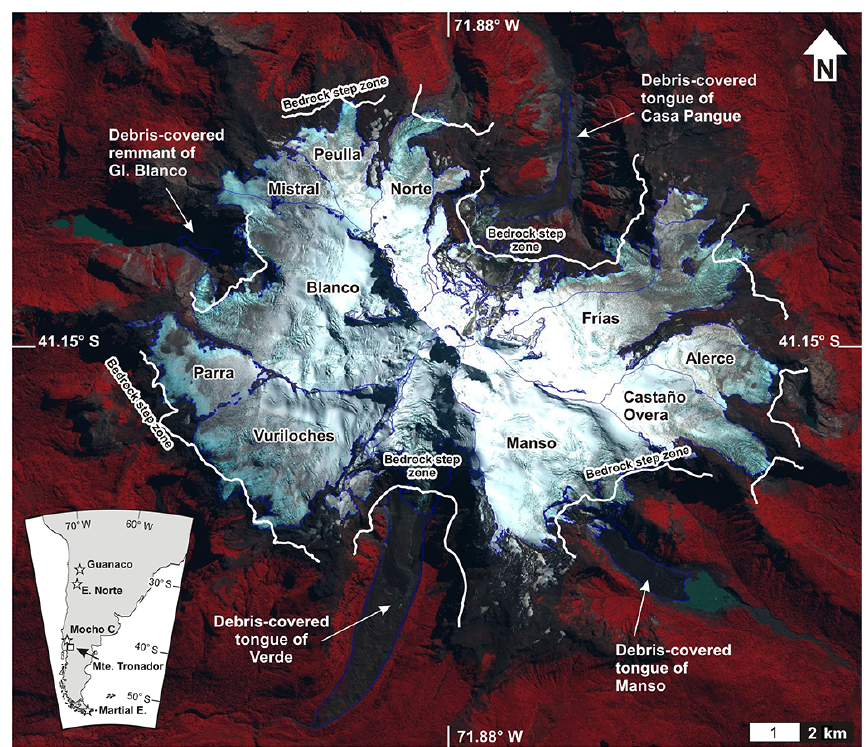
Figure 1. False-colour pan-sharpened Pléiades image of Monte Tronador from 7 March 2012 (RGB bands 3, 2 and 4, © CNES 2012, Distribution Airbus D&S). Individual glacier limits are indicated by the thin blue line. The thick white line shows the location of the bedrock cliff discussed in the text. The inset shows the location of Monte Tronador and other glaciers with long mass balance measurement series in the Southern Andes (22–55 ◦